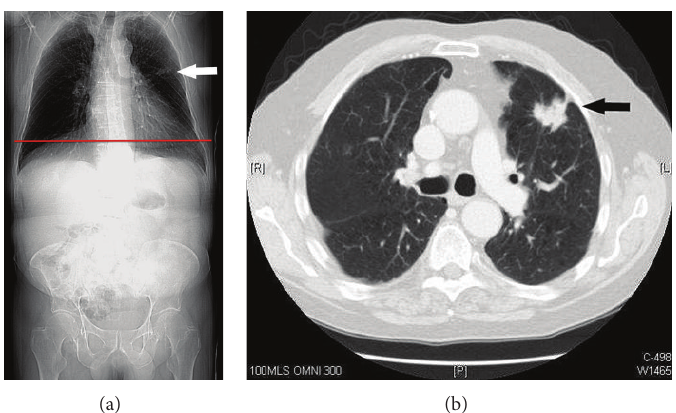
Figure 2: (a) CT scout (AP) view demonstrates a nodule in the left midzone (white arrow). The level of the first axial image from the surveillance abdominopelvic CT is shown by the red line demonstrating that the scan commenced below the level of the lesion. (b) Image from CT chest scan confirmed a soft tissue attenuation spiculated nodule with a pleural tag in the anterior segment of the left upper lobe (black arrow).